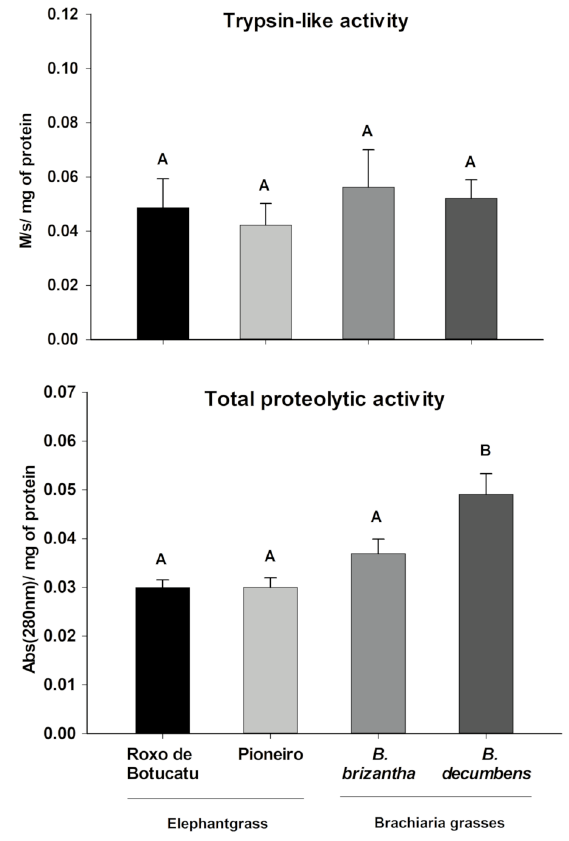
Figure 4. Trypsin-like activity and total proteolytic activity analyzed in the midgut of Mahanarva spectabilis adults fed on different forage grasses (cvs. Roxo de Botucatu and Pioneiro of elephant grass, B. brizantha and, B. decumbens ). Bars (mean ± SE; n = 4) with the same letters indicate no significant difference between treatments (Tukey’s test: P <